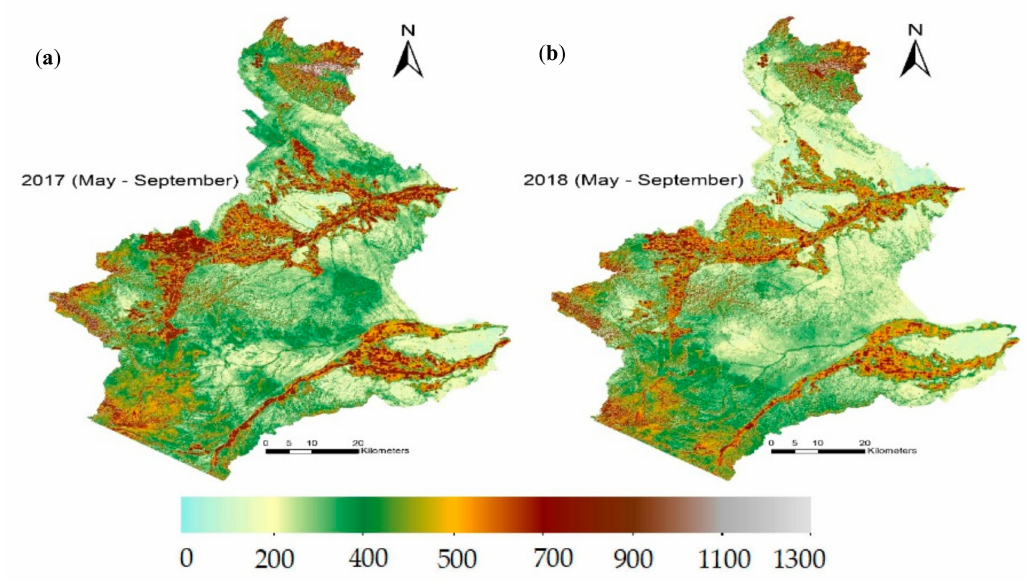
Figure 10. Spatio-temporal distribution of METRIC estimated seasonal ETc (mm) during ( a ) 2017 and ( b ) 2018 growing season